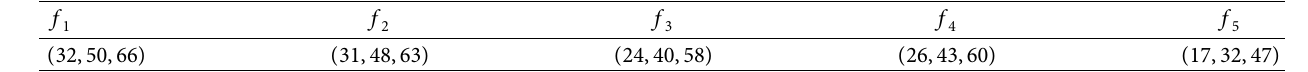
Table 14: The impact of different service capabilities on overall service quality. f 2